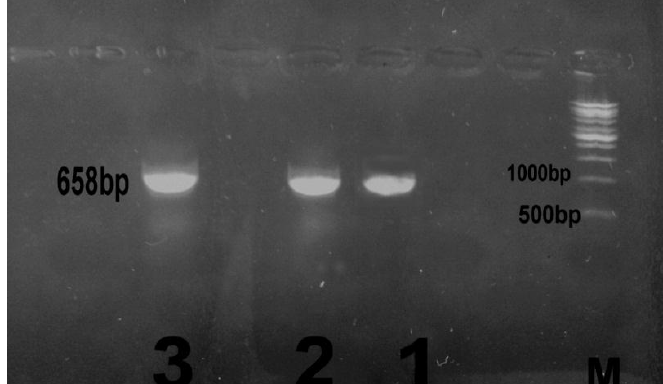
Fig. 1—Showing amplicon of 658 bp of CPV-2a or CPV-2b positive samples using pCPV-2ab (F and R) primers: Lane M, DNA marker 5 kbp; lane 1, 681 bp PCR product of sample no. 1, lane 2, 681 bp PCR product of sample no. 2; lane 3, 681 bp PCR product of positive control (puppy vaccine).